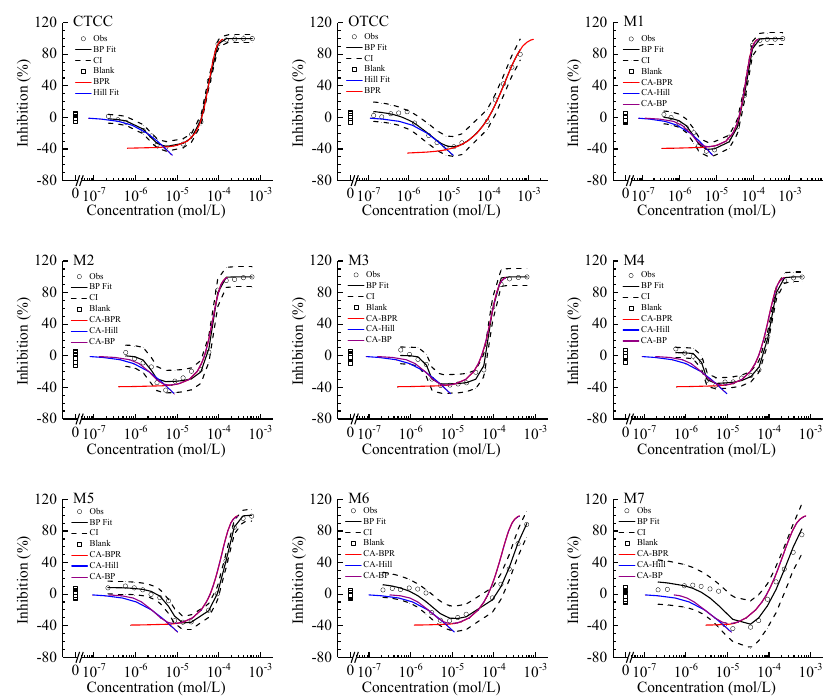
Figure 1. Concentration–response curves of chlortetracycline hydrochloride (CTCC), oxytetracycline hydrochloride (OTCC) and their mixtures inhibiting Allivibrio fischeri . Note: Square: blank control; Circle: observed data; Black dashed line: confidence interval; Black solid line: BP fit; Red line: BPR fit for single components or CA prediction based on BPR function for mixtures; Blue line: Hill fit for single components or CA prediction based on Hill function for mixtures; Violet line: CA prediction based on BP function; M1–M7 are the mixtures of CTCC and OTCC mixing with the molar ratios of 12:1, 10:3, 8:5, 1:1, 5:8, 3:10, and 1:12 respectively.